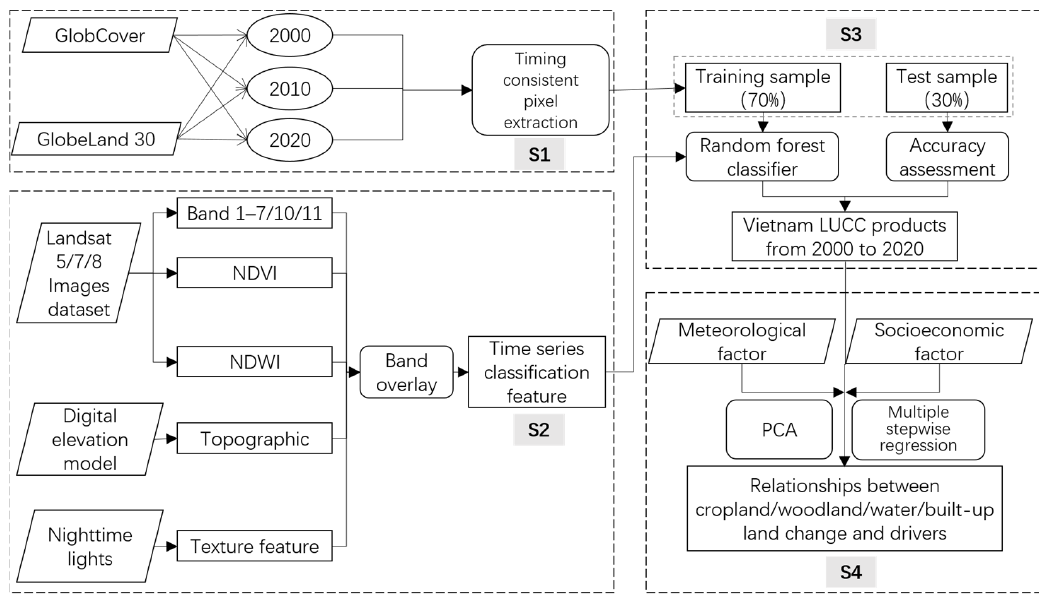
Figure 2. Technical flowchart of land use/land cover mapping and driving mechanism analysis.